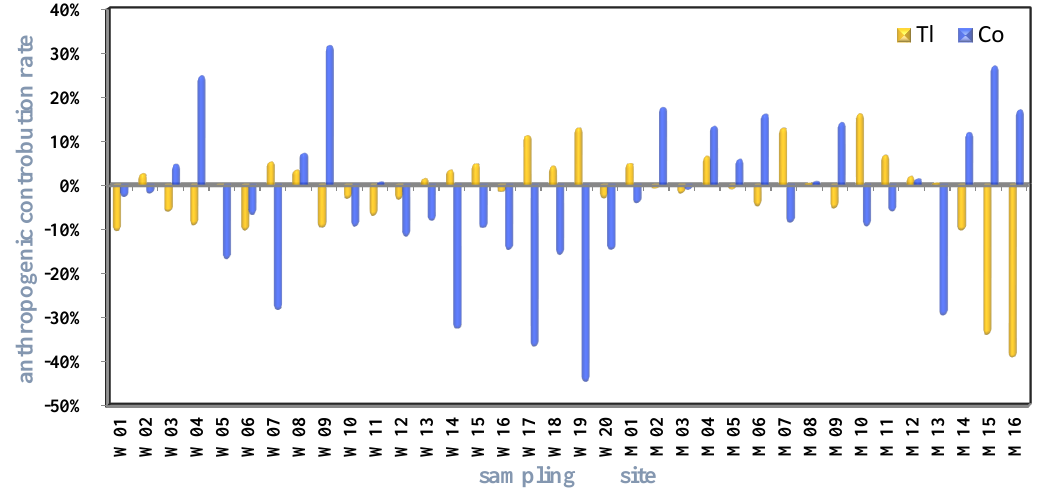
Figure 4. Anthropogenic contribution rate of Tl and Co at each sampling site.